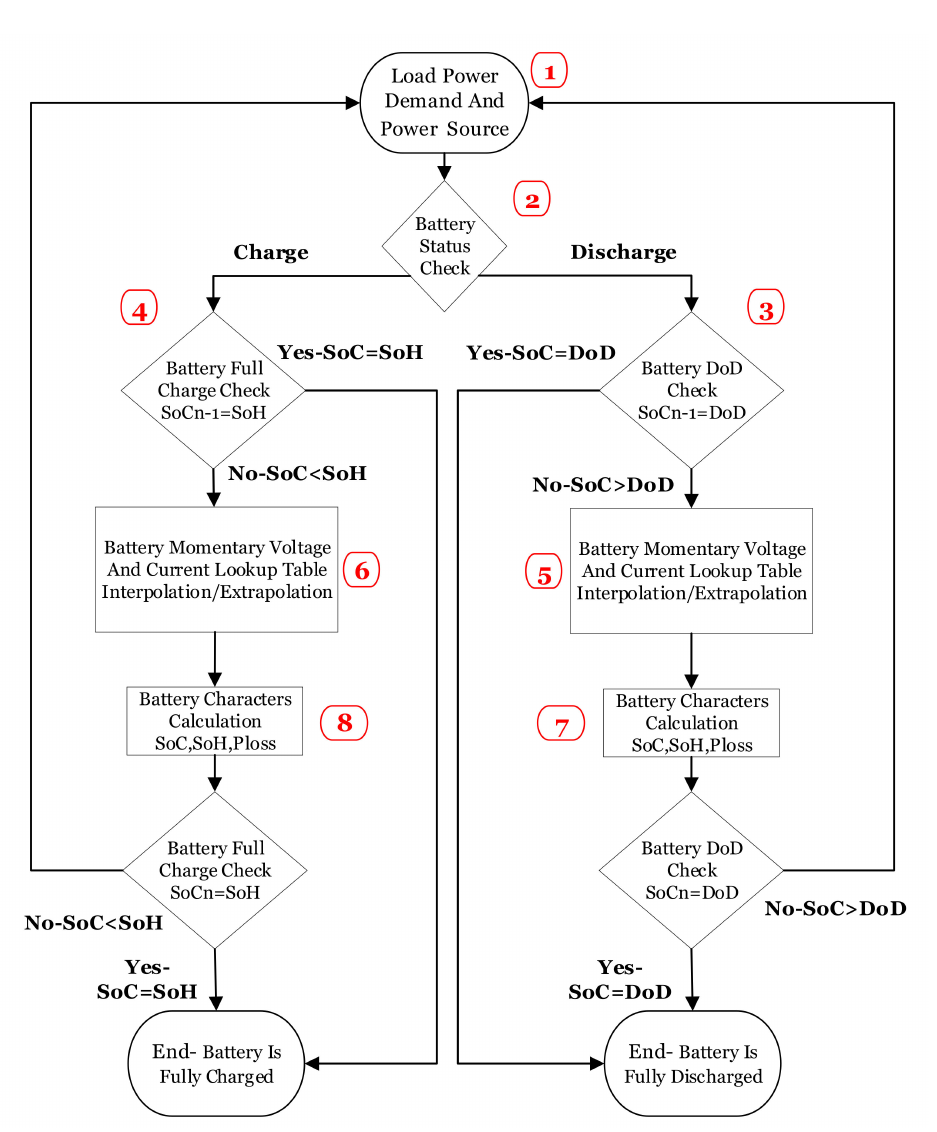
Figure 7. Generic ESS Model